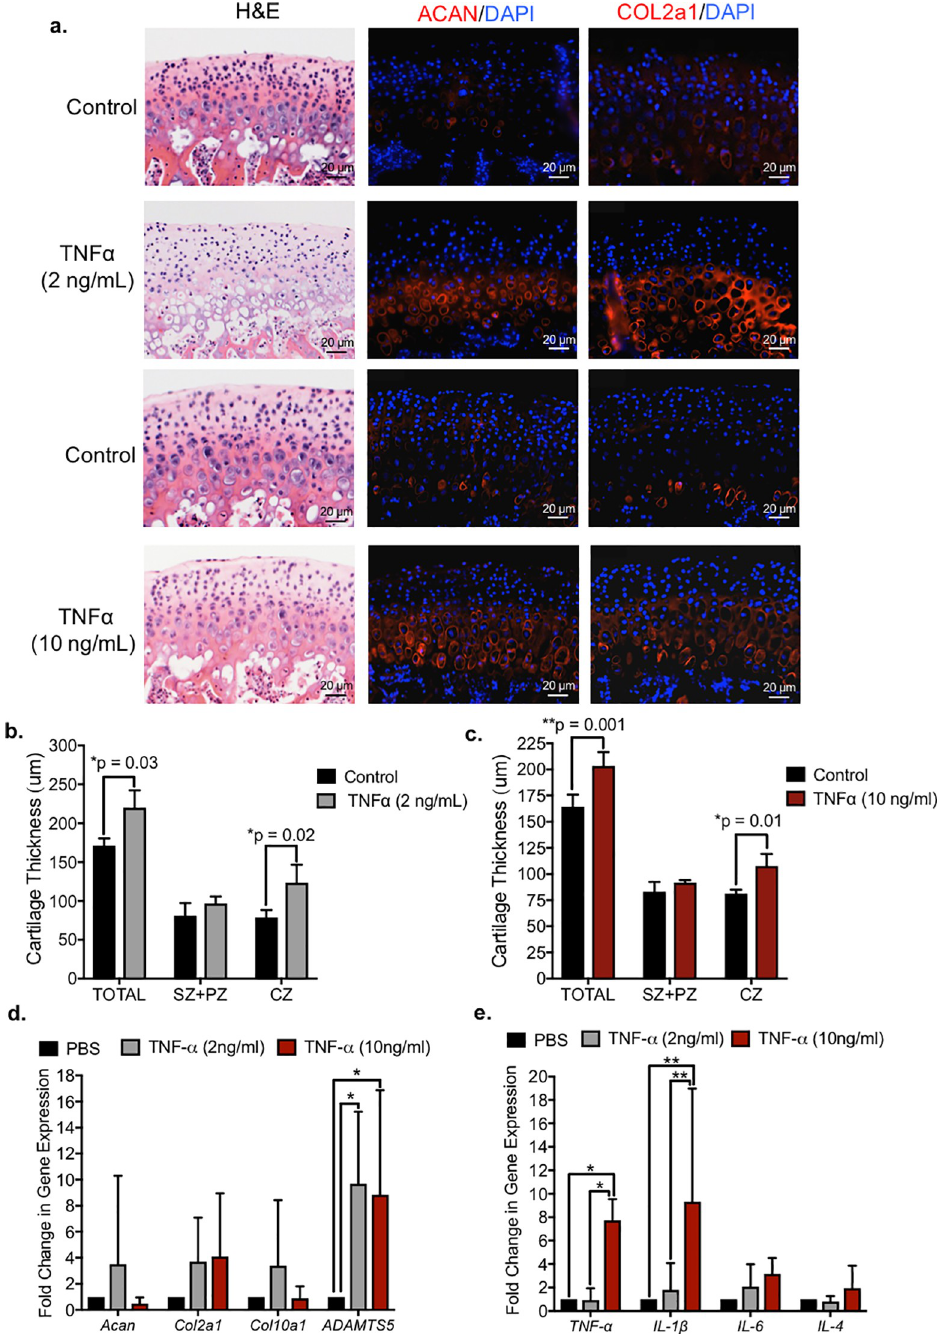
Fig 2. TNF-alpha increases extracellular matrix turnover and inflammatory cytokines in whole mandibular condyle explants. (a) Whole TMJ condyle explants were cultured for 48 hours in media supplemented with vehicle control, 2 ng/ml or 10 ng/ml rhTNF-alpha. Representative and comparable histological sections from explants were stained with H&E. Immunohistochemistry (red) showed increase in aggrecan (ACAN) and type II collagen (COL2a1) expression in explants treated with rhTNF-alpha. Scale bar = 20 μ m. Isotype-matched negative control antibodies were used under the same conditions. (b , c) TMJ condyle explants treated with 2 ng/ml and 10 ng/ml rh-TNF-alpha had significantly increased total cartilage thickness and also within chondrocyte zone (CZ) as delineated by COL2a1 + expression relative to vehicle control explants. Data are mean ± SD; n = 3 explants; two-way ANOVA followed by Tukey’s post hoc. SZ = superficial zone; PZ = polymorphic zone; CZ = chondroctye zone as defined by Col2a1 expression. ( d , e) qRT-PCR using total RNA extracted from TMJ condyle explants treated with vehicle, 2 ng/ml rhTNF-